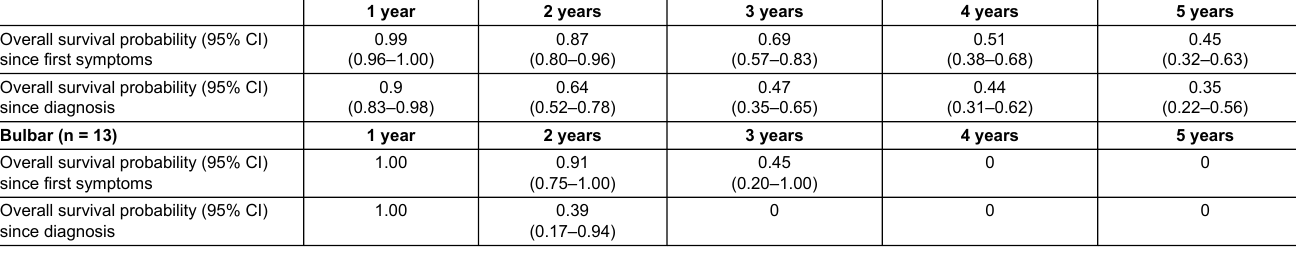
Table 3: Overall survival among patients from first symptoms and from diagnosis of ALS; n =